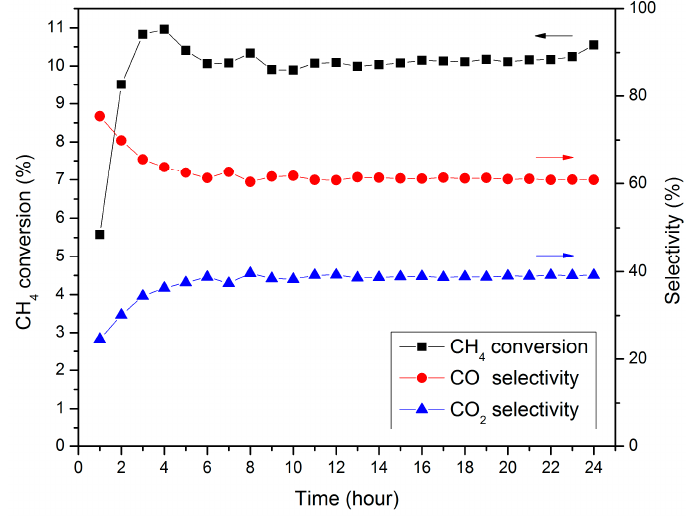
Figure 11. Time-on-stream testing results of 2Cr3Ru / Al 2 O 3 catalyst during 24 h. Reaction conditions: feed gas O 2 / CH 4 volume ratio = 3 / 5, GHSV = 15,000 h − 1 , and reactor temperature = 475 ◦ C.